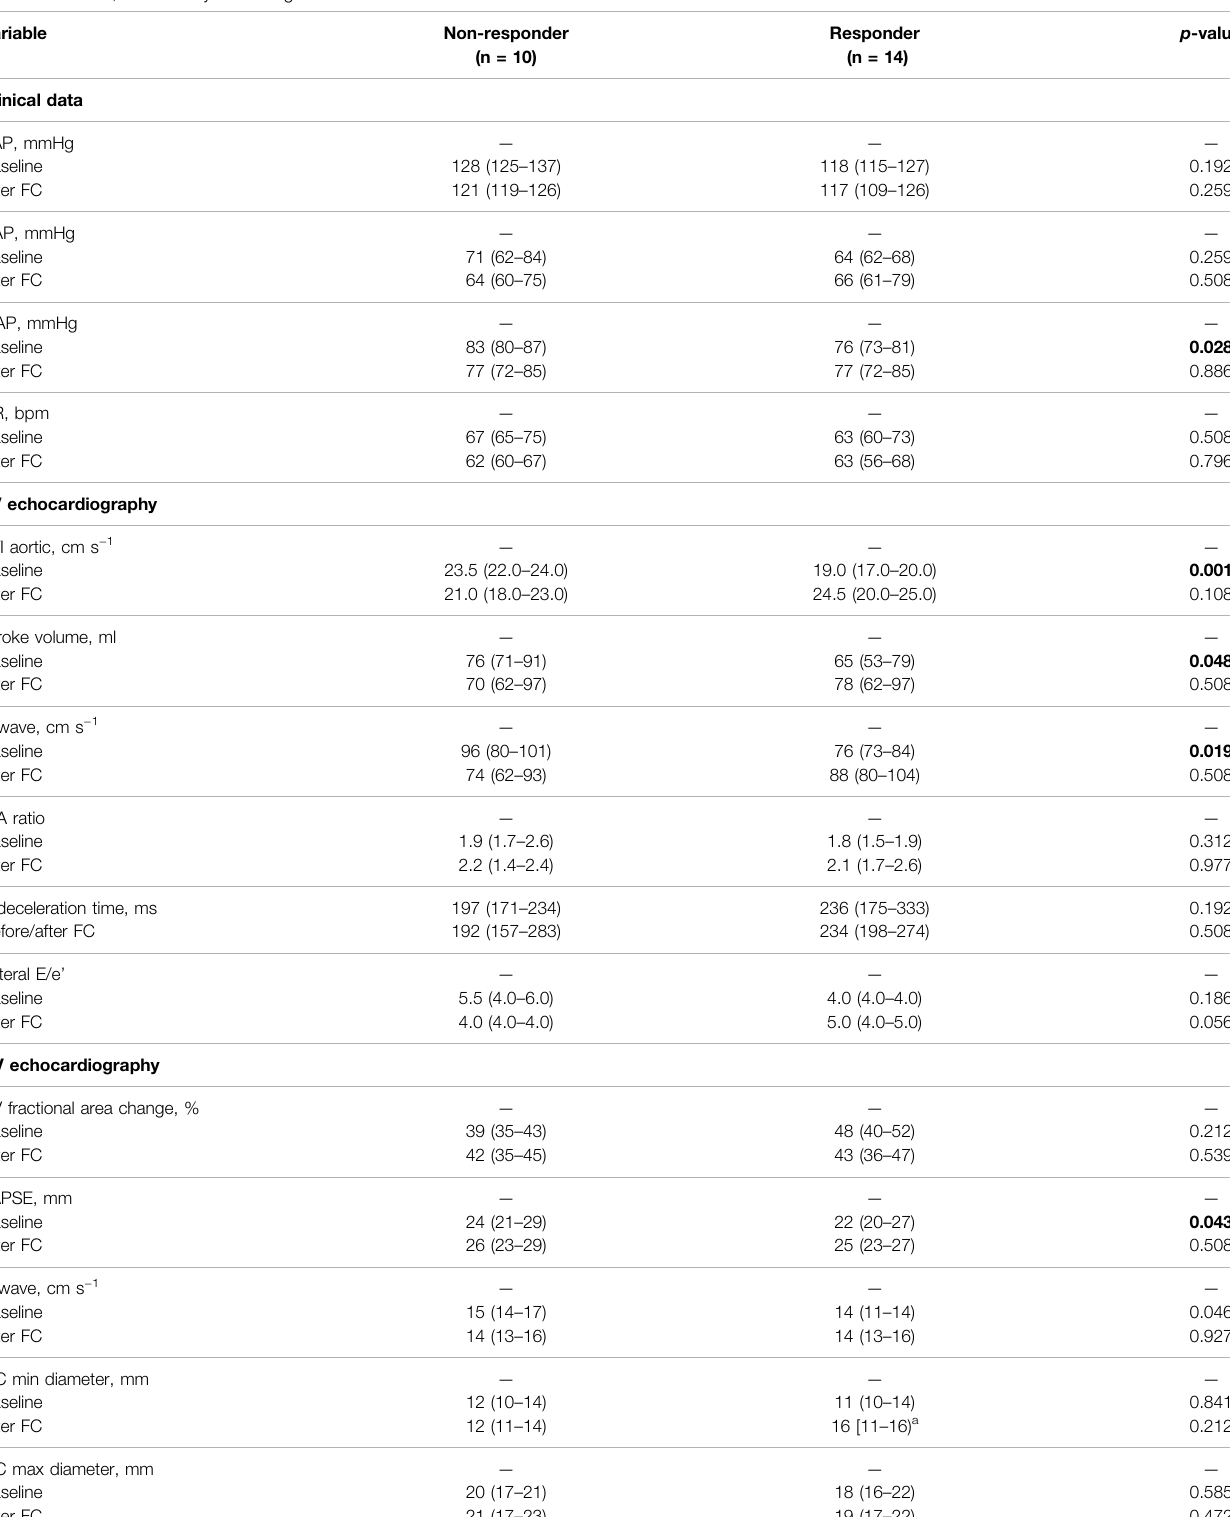
TABLE 2 | Clinical data and left ventricular (LV) and right ventricular (RV) echocardiographic parameters in non-responders and responders after 500 ml of fl uid challenge (FC). SAP:systolic arterialpressure; DAP:diastolicarterial pressure; MAP:mean arterial pressure;HR: heartrate;IVC: inferior venacava;TAPSE: tricuspid annularplane systolic excursion; VTI: velocity – time